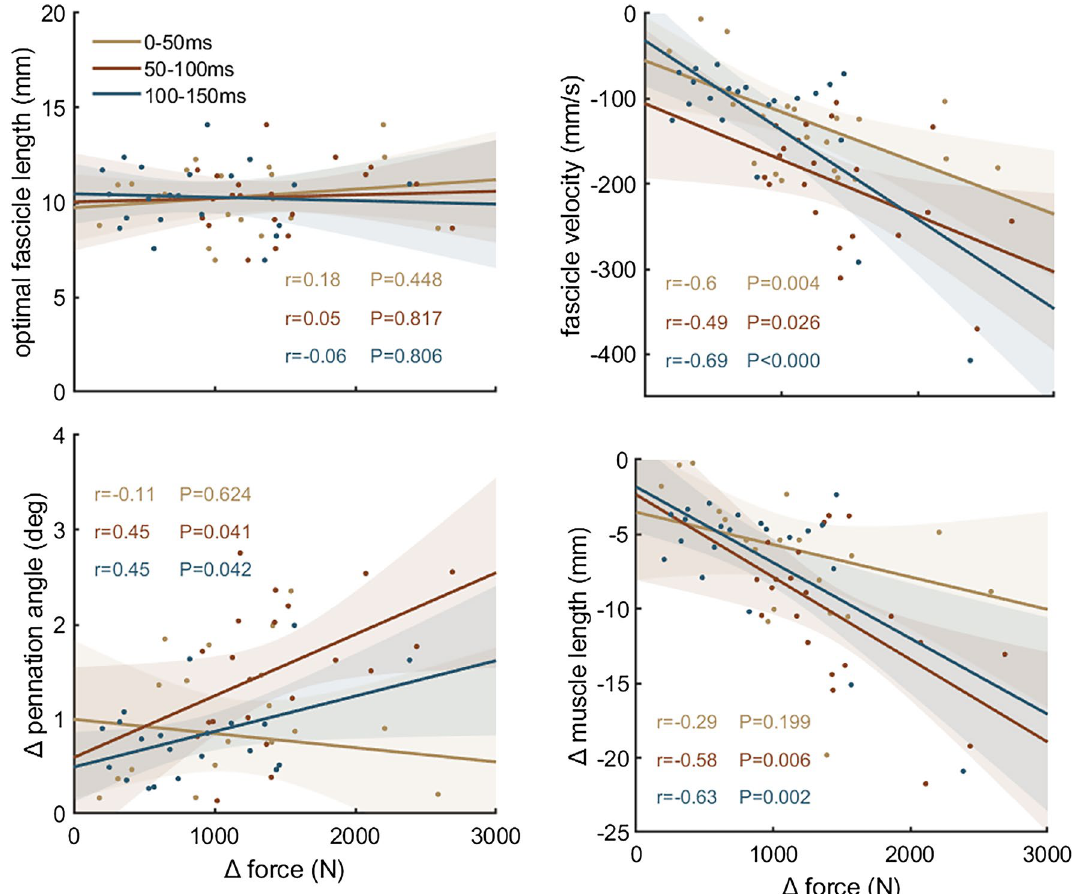
Figure 2. Correlation analysis between absolute force increase during rapid contractions and optimal fascicle length, fascicle velocity, change in pennation angle and muscle length change (n = 21). Optimal fascicle